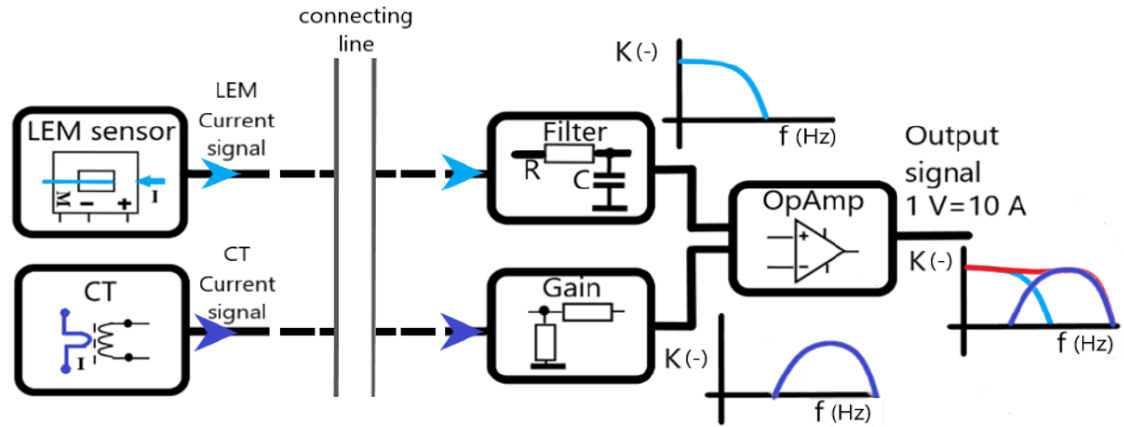
Figure 1. General concept of the ALCS as a bloc diagram.